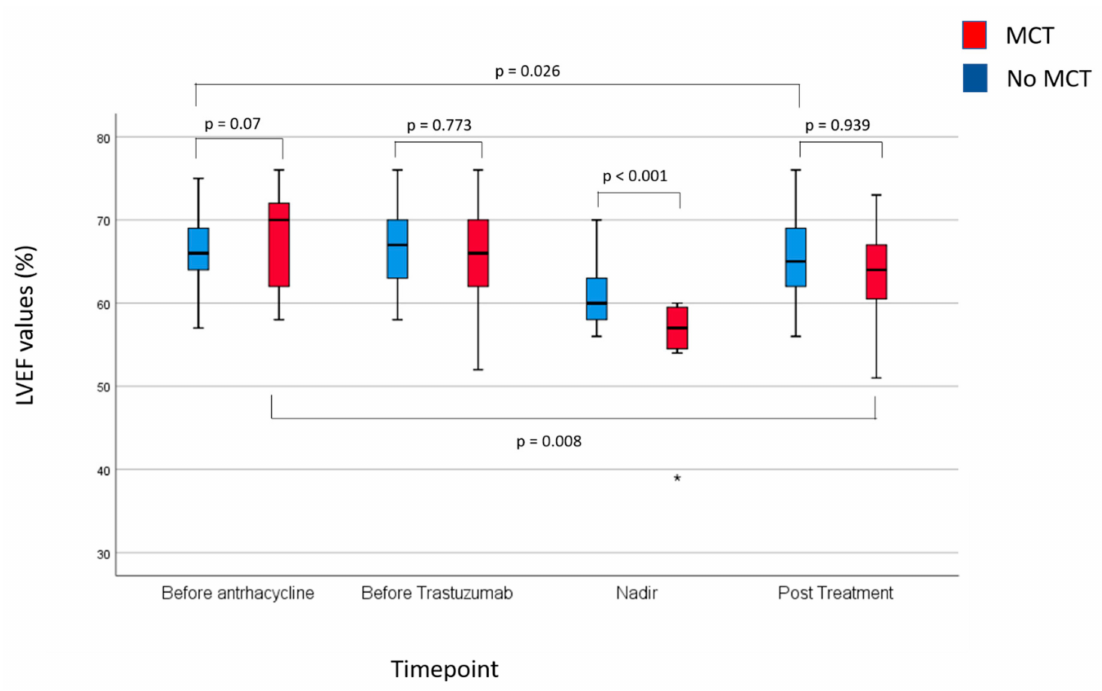
Figure 3. Summary of LVEF findings at baseline, LVEF nadir and post-treatment according to the occurrence of the cardiac event of interest. The box extends from the 25th to the 75th percentile. The line is the median LVEF value. The lines extend to the largest and smallest observed values within 1.5 box lengths; “o” symbols represent outliers (values between 1.5 to 3 box lengths from the upper or lower edge of the box), asterisks represent extreme values (values of more than 3 box lengths from the upper or lower edge of the box).